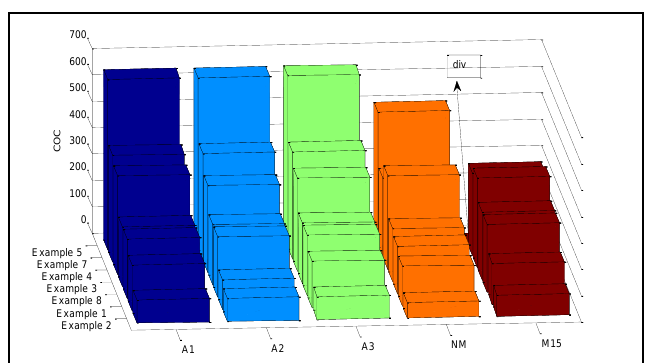
Fig. 11. Error drops for example 8